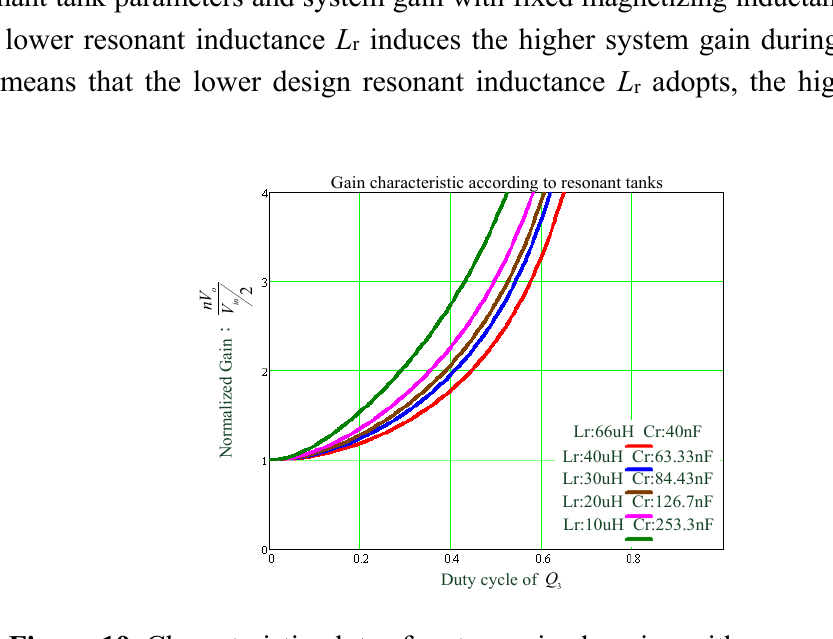
Figure 19. Characteristic plots of system gain changing with resonant